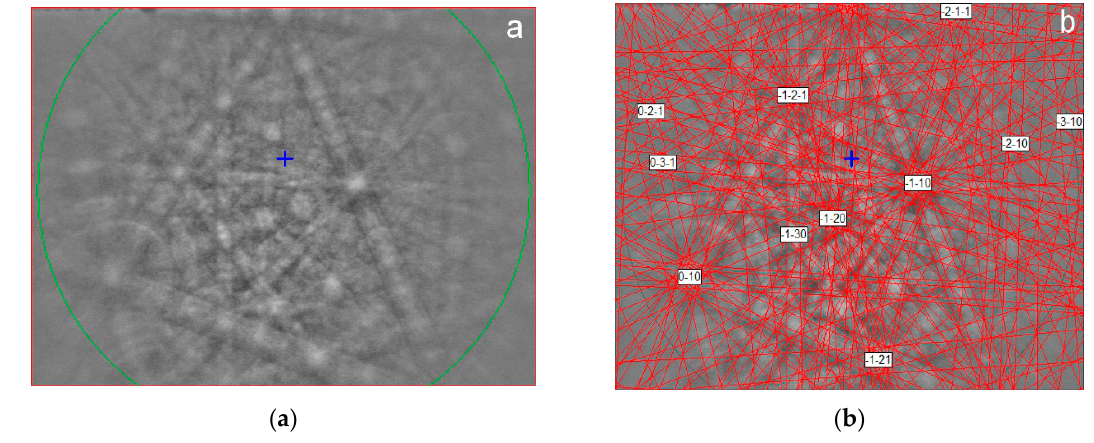
Figure 6. The observed and indexed EBSD patterns ( a and b , respectively) obtained for micrometer-sized inclusion of geversite hosted by the placer grain of platiniferous tetra-auricupride at Bolshoy Khailyk.